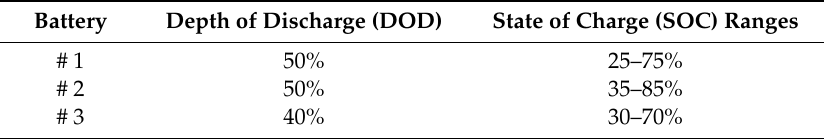
Table 2. Cycling-induced aging test (CAT) profile